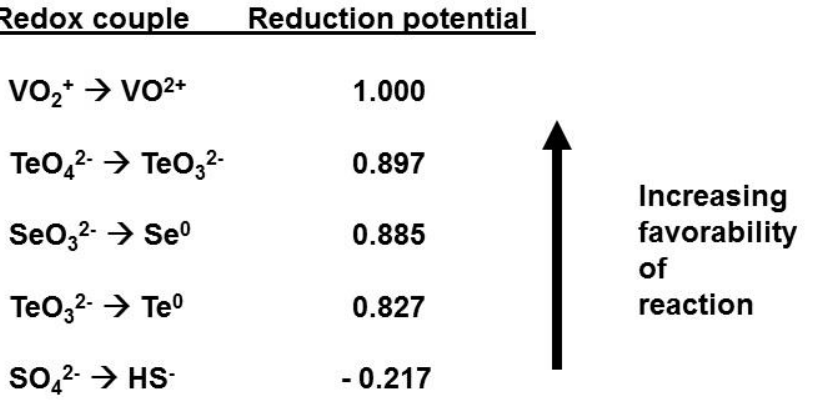
Figure 7. Energetics of Te, Se, and V oxyanion redox couples showing they are more favorable for anaerobic respiration than the SO 2 − / HS − redox couple used by sulfate-reducing bacteria.